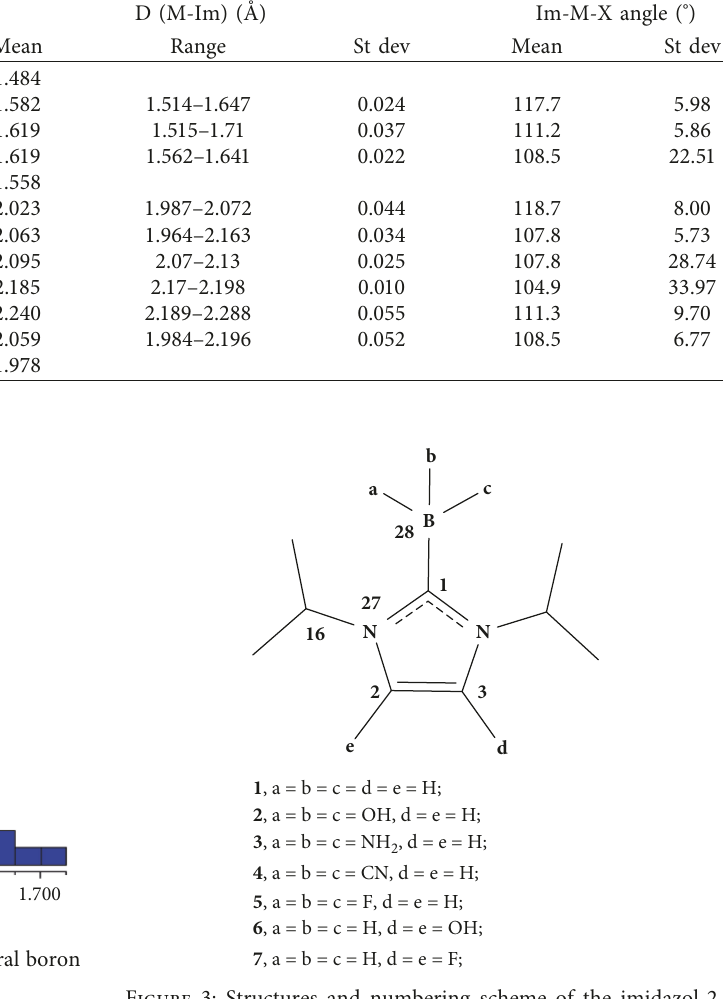
Figure 3: Structures and numbering scheme of the imidazol-2- ylidene stabilized